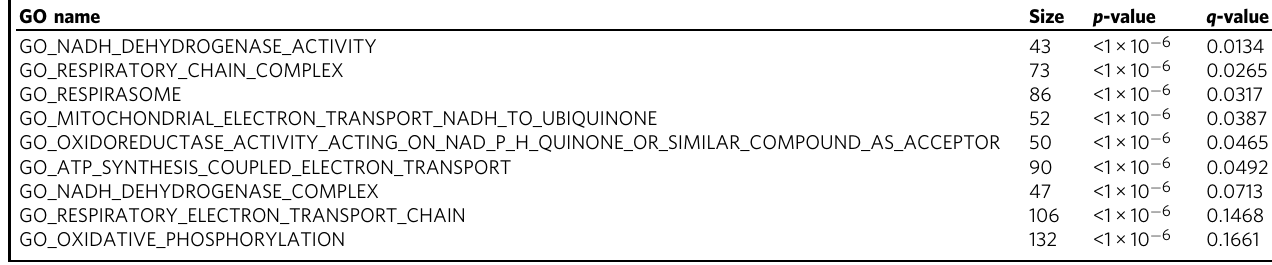
Table 1 Gene Ontologies (GOs) suppressed by Opti-ELF-WMF in mouse hepatocyte-derived AML12 cells at 1 h by Gene Set Enrichment Analysis